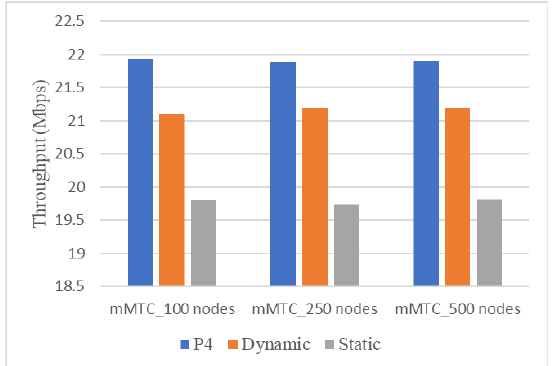
Figure 12. Average throughput in the URLLC slice.